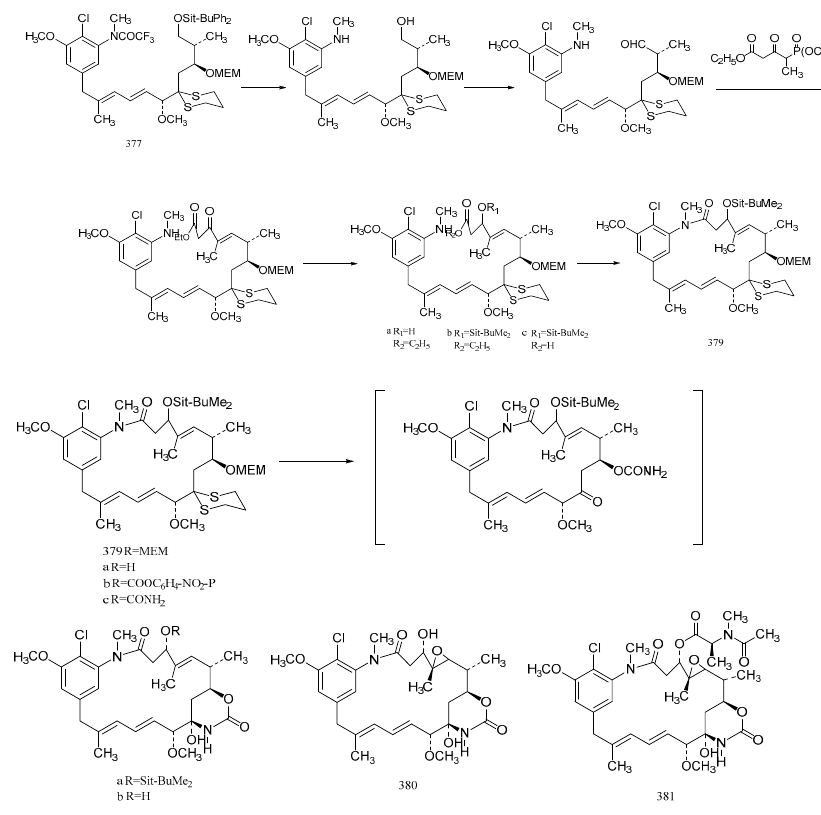
Figure 24. The final steps in the synthesis of maytansine.